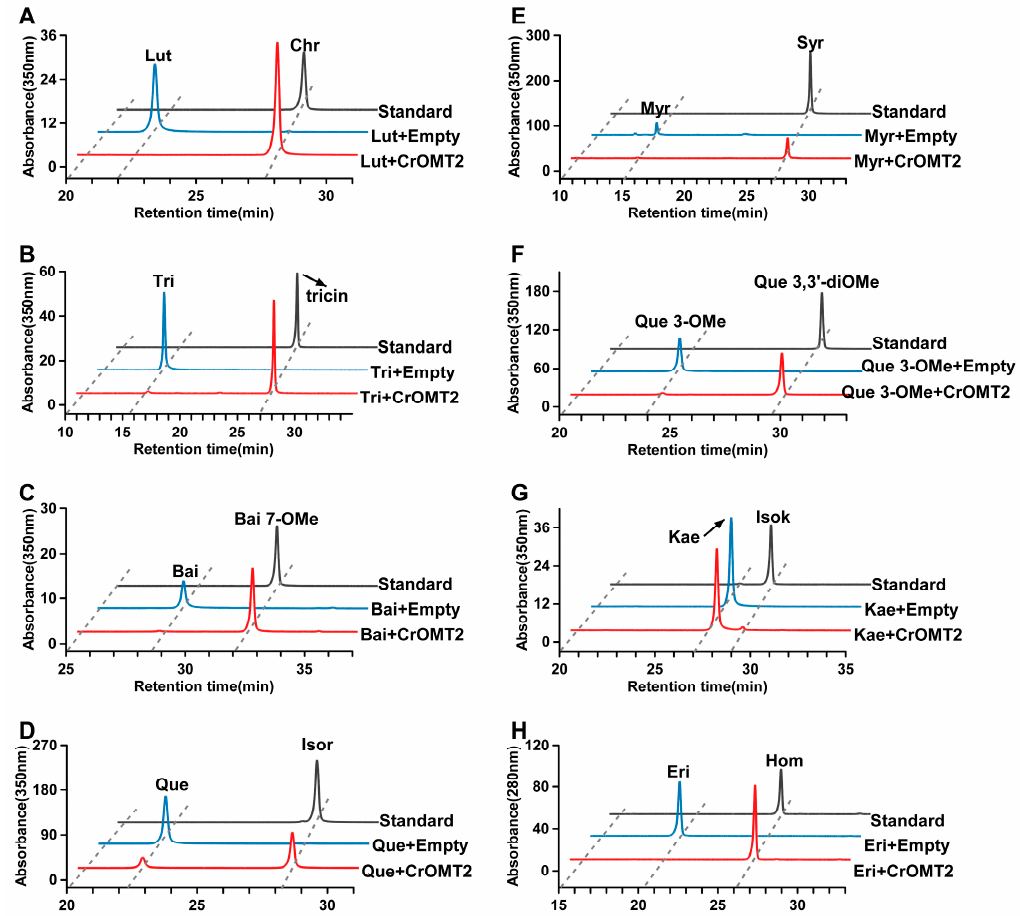
Figure 3. HPLC analysis of products catalyzed by Citrus reticulata O -methyltransferase 2 (CrOMT2). The methylated products produced by the recombinant CrOMT2 were identified by comparison of the retention times and MS / MS data with corresponding standards (see Supplementary Figure S3 for the MS / MS data of standards). HPLC chromatograms of enzyme reactions with luteolin ( A ), tricetin ( B ), baicalein ( C ), quercetin ( D ), myricetin ( E ), quercetin 3-methyl ether ( F ), kaempferol ( G ), and eriodictyol ( H ) are indicated. Substrates catalyzed by CrOMT2 indicated in red; substrates incubated with empty vector (pET32a) indicated in blue, commercial standards of the methylated products indicated in